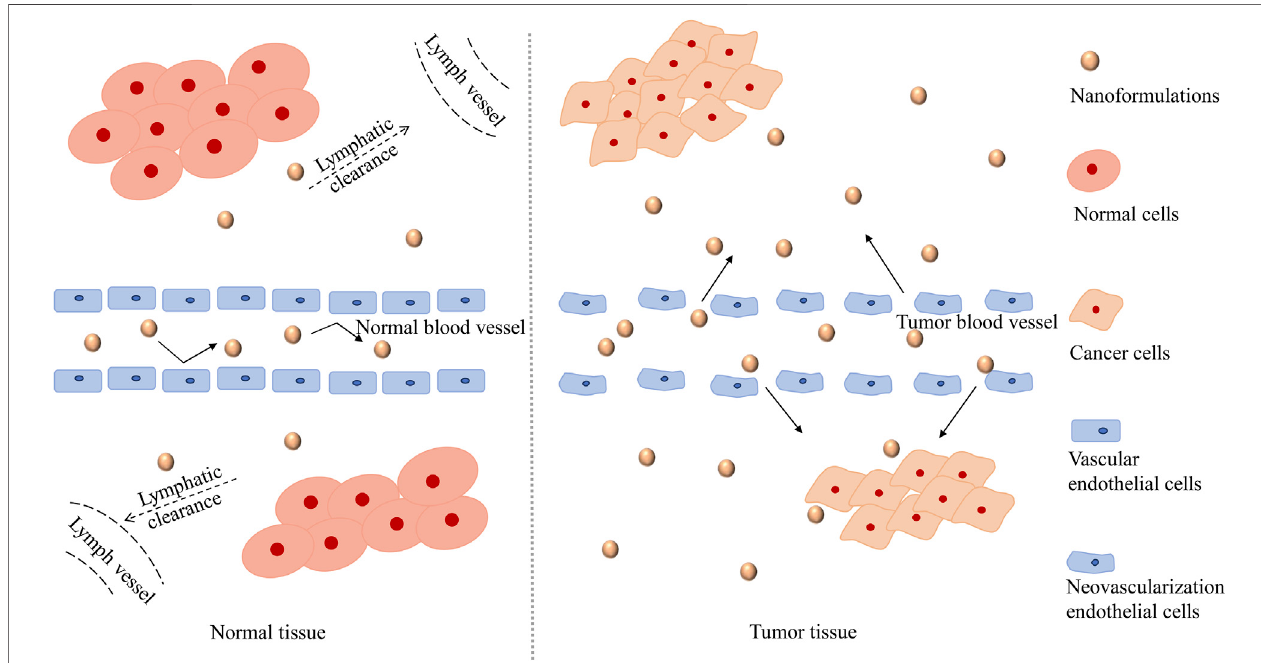
Frontiers in Pharmacology |